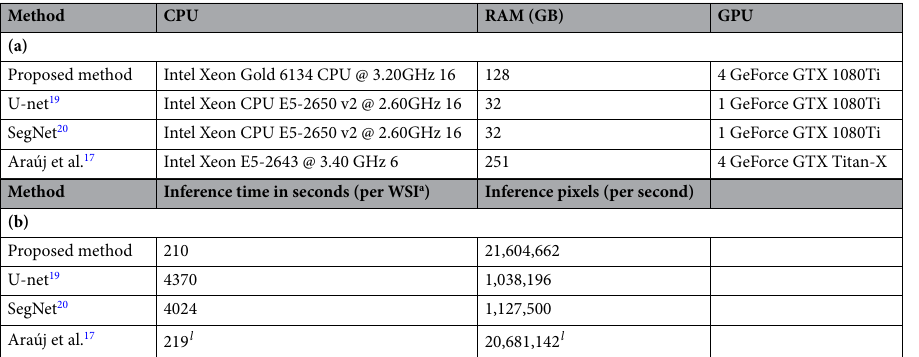
Table 5. Comparison on (a) hardware and (b) computing efficiency. a The size of the WSI in this evaluation is 4,536,979,200 pixels (99,600 × 45,552 pixels). b Araúj et al.’s method 17 takes 0.07 s for processing a patch with 1392 × 1040 pixels; b 219 s = (cid:31) 99,600 × 45,552 1,392 × 1040 × 0.07 (cid:30) ; 20,681,142 pixels = ⌊ 1392 × 1040 ÷ 0.07 ⌋